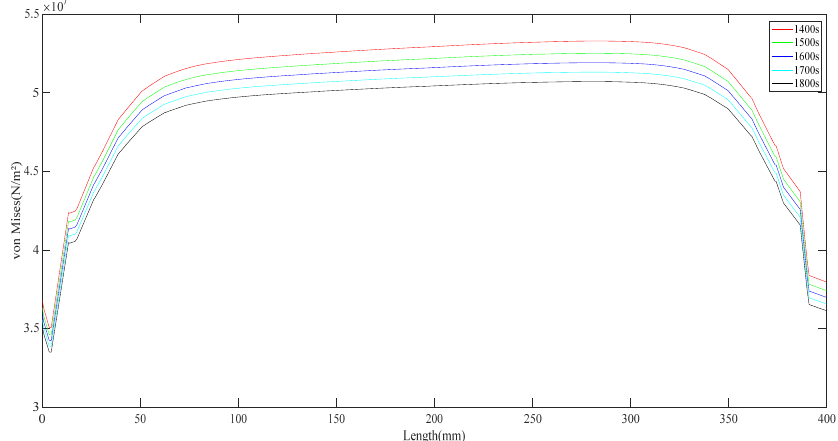
Figure 3. Equivalent force distribution for different heat dissipation periods.